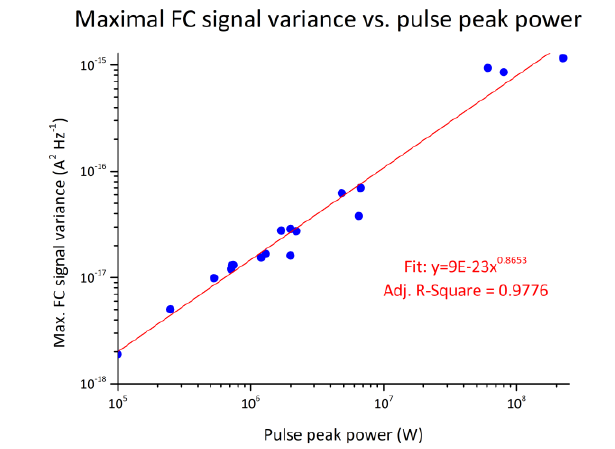
Fig. 6. Preliminary linearity of 238 U FC signals versus reactor peak